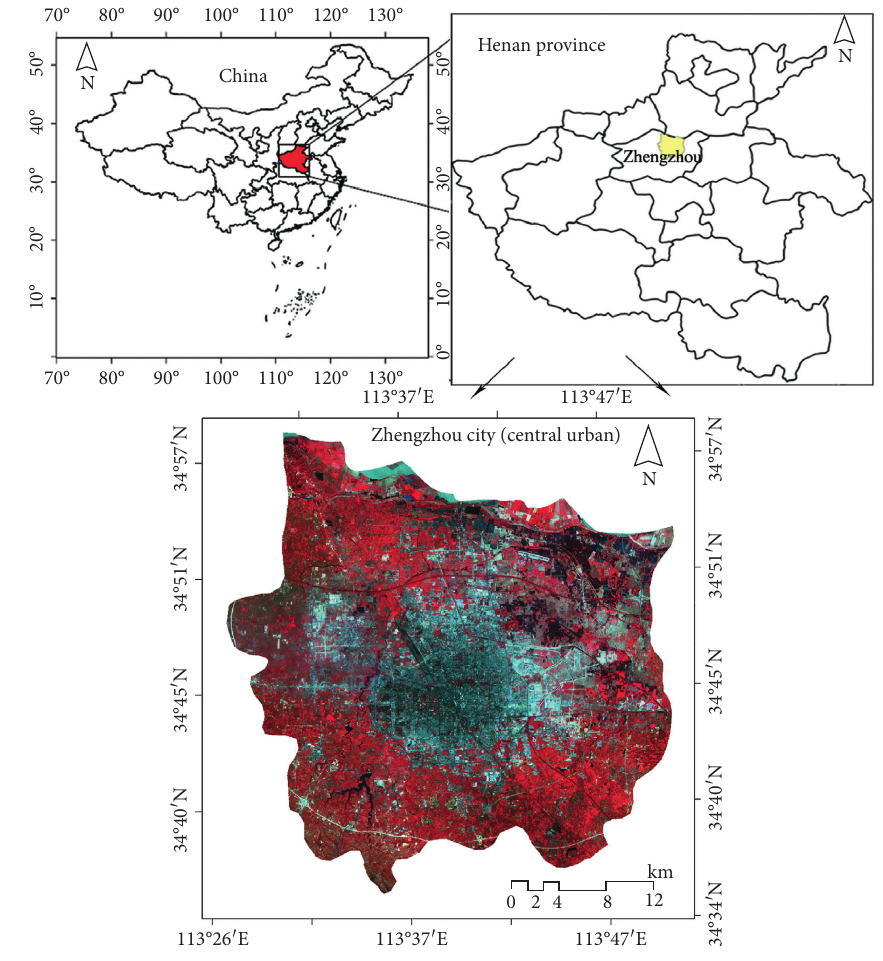
Figure 2: Location map of the study site. Table 1: The classification of LST zones